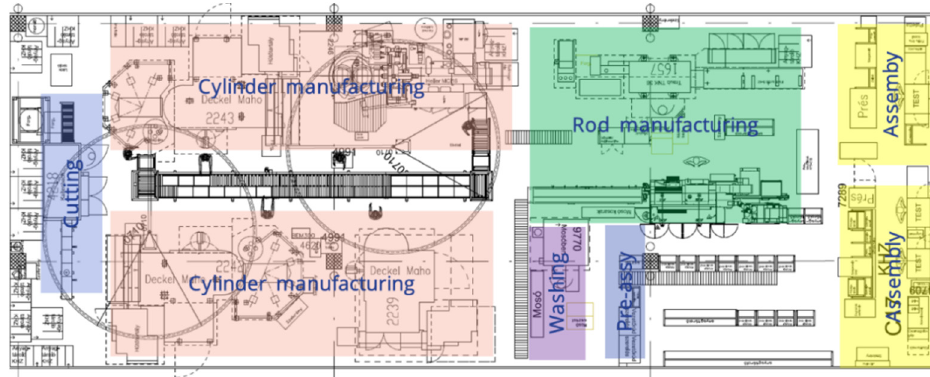
Figure 4. Layout and operations of the mini-factory investigated.